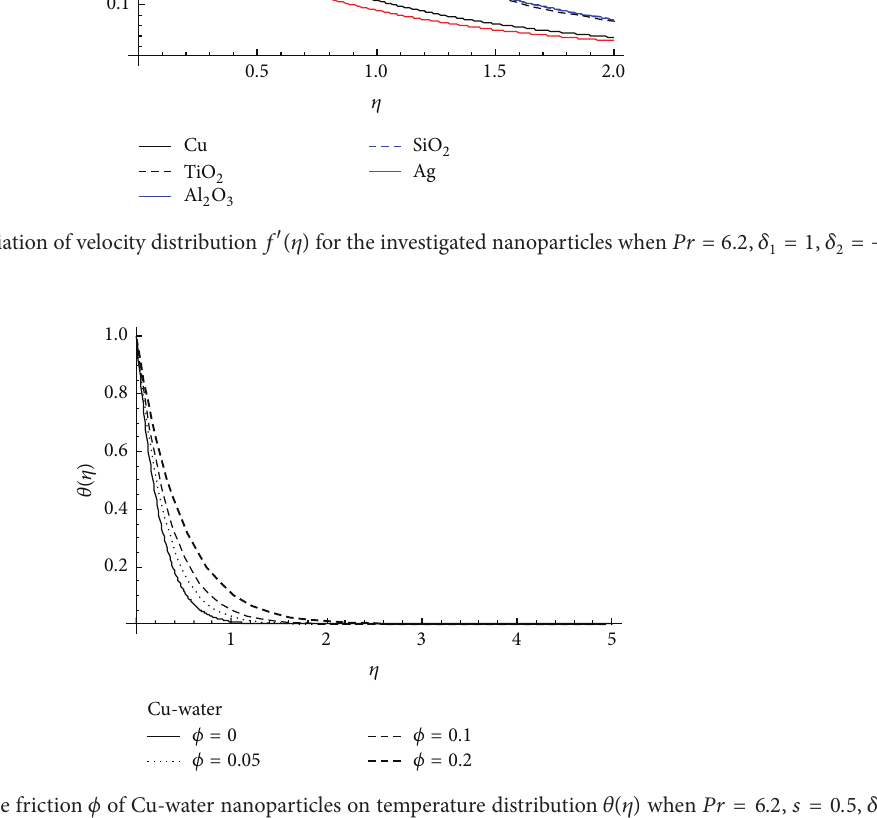
Figure 16: Effect of the volume friction 𝜙 of Cu-water nanoparticles on temperature distribution 𝜃(𝜂) when 𝑃𝑟 = 6.2 , 𝑠 = 0.5 , 𝛿 1 = 1 , and = −1 𝛿 2